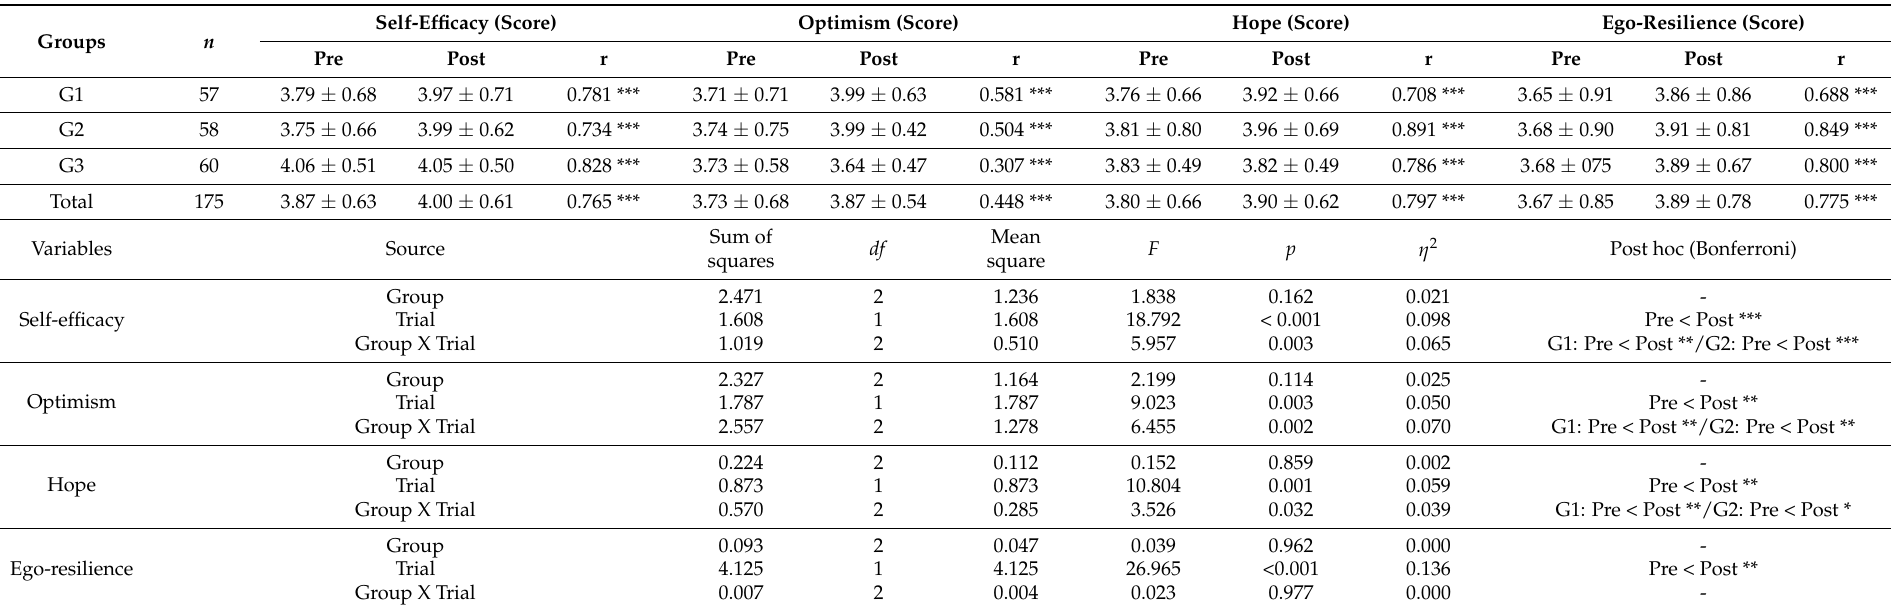
Table 5. Positive psychological capital pre- and post-exercise among the three participant